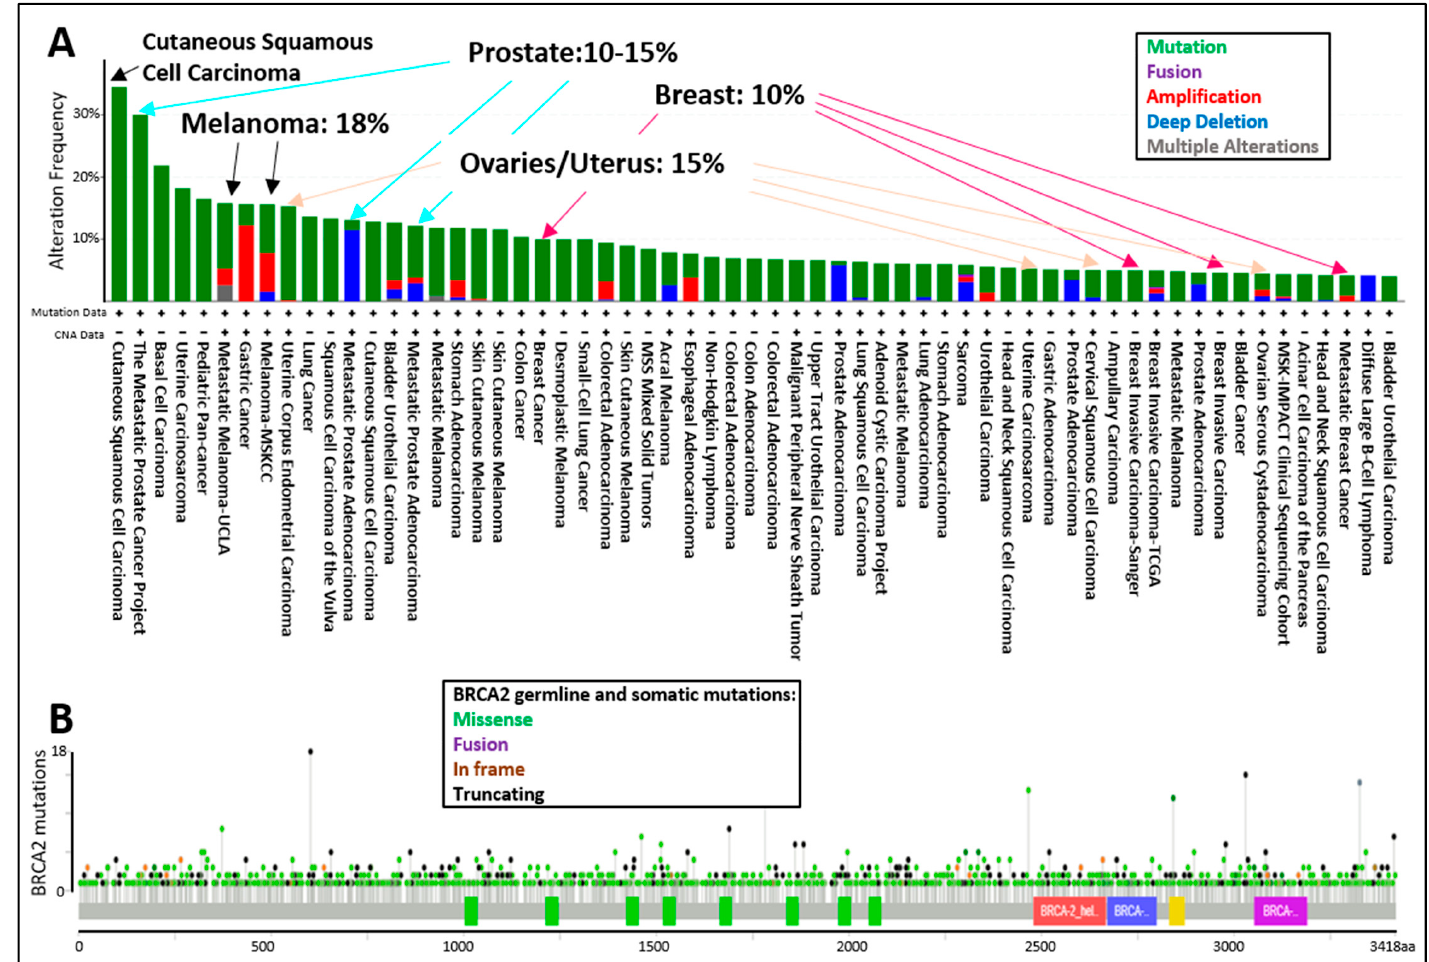
Figure 4. cBioPortal for Cancer Genomics display of the ( A ) percentage of BRCA2 germline and somatic alterations and ( B ) spectrum of BRCA2 germline and somatic mutations in the different protein domains. The curated set of non-redundant studies of cBioPortal for Cancer Genomics was used. Combined study with 48,081 samples and 184 studies. Graphs display BRCA2 somatic mutation frequency of 3% and BRCA2 germline mutation frequency of <0.1.